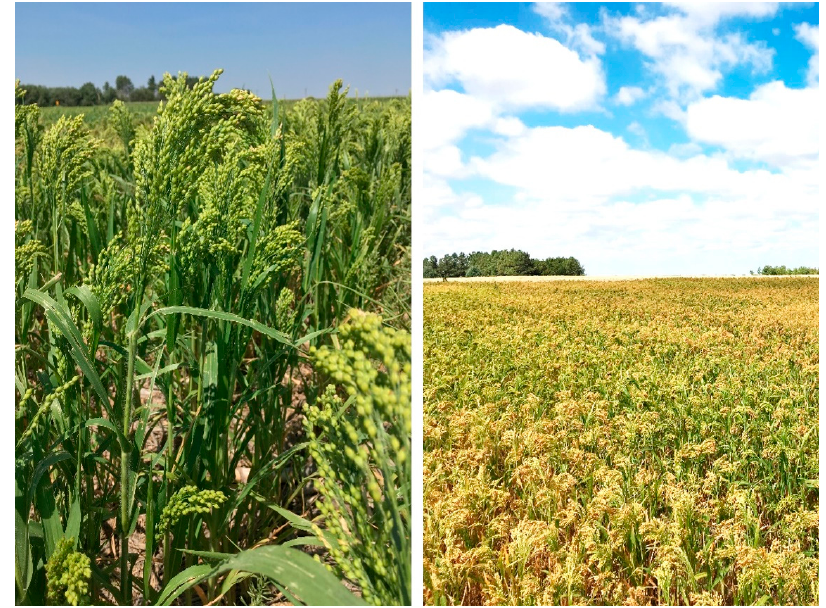
Figure 2. Proso millet ( Panicum miliaceum L.).